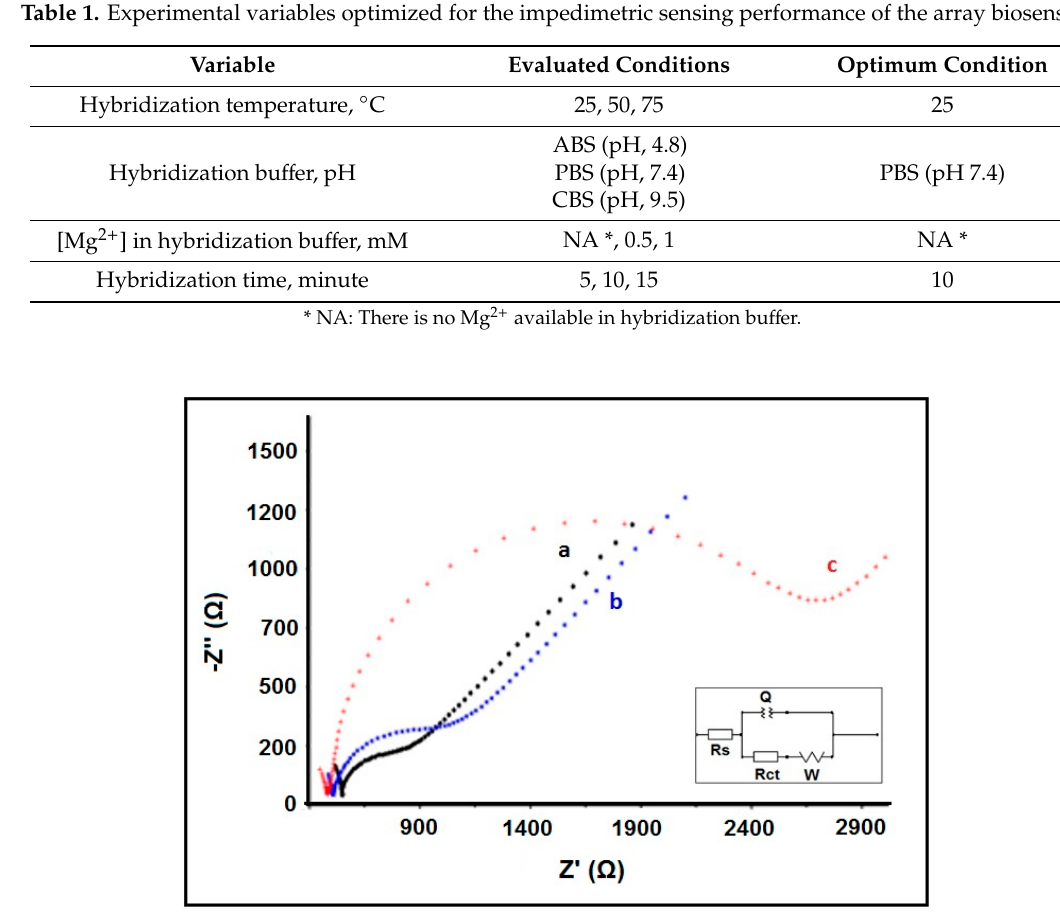
Figure 1. The Nyquist diagrams obtained after the hybridization of the Z-probe and mutant type DNA target under optimized conditions. ( a ) Electrode control, ( b ) Z-probe in the absence of target, ( c ) the hybrid form of Z-probe and mutant type DNA target.